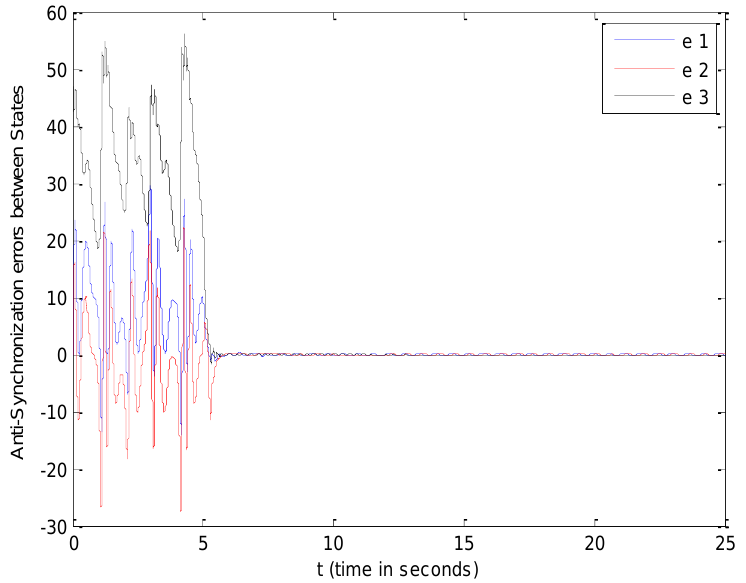
Figure 3. Fractional order derivative with 𝛼 = 0.9,𝛼 = 0.8 and 𝛼 = 0.5 , time delay 𝜏 = 5 s. Time-de- lay synchronization errors between the states of master and slave systems.